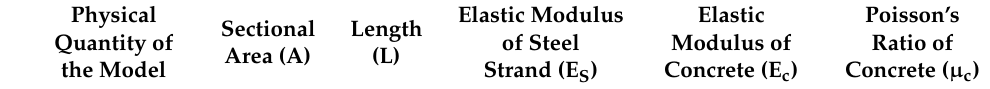
Table 1. Partial similarity coefficient of the model.